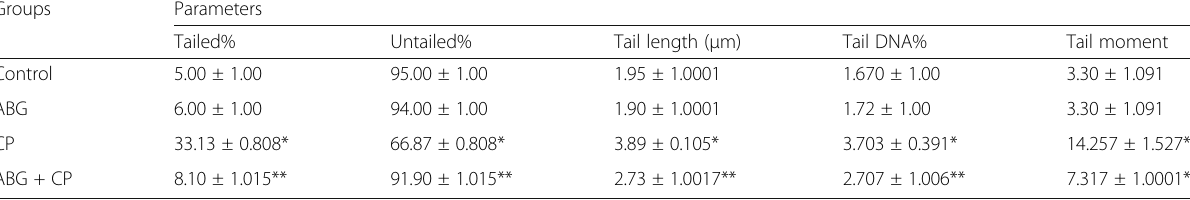
Data are represented as mean±SD, n =7 *Significant increase at P <0.05 compared with the control group **Significant decrease at P <0.05 compared with the cyclophosphamide